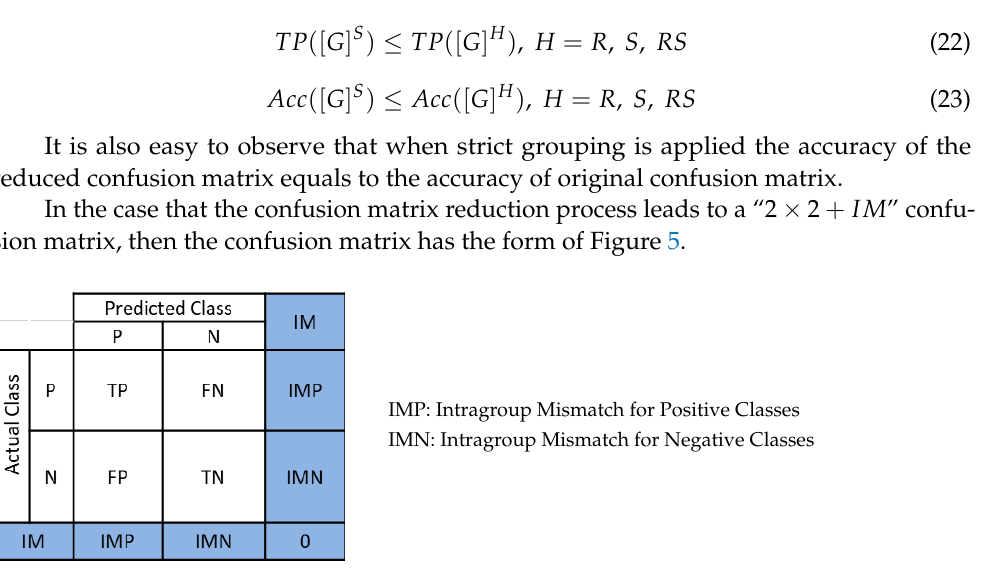
Figure 5. The concept of reduced confusion matrix in “2 × 2 + IM ”